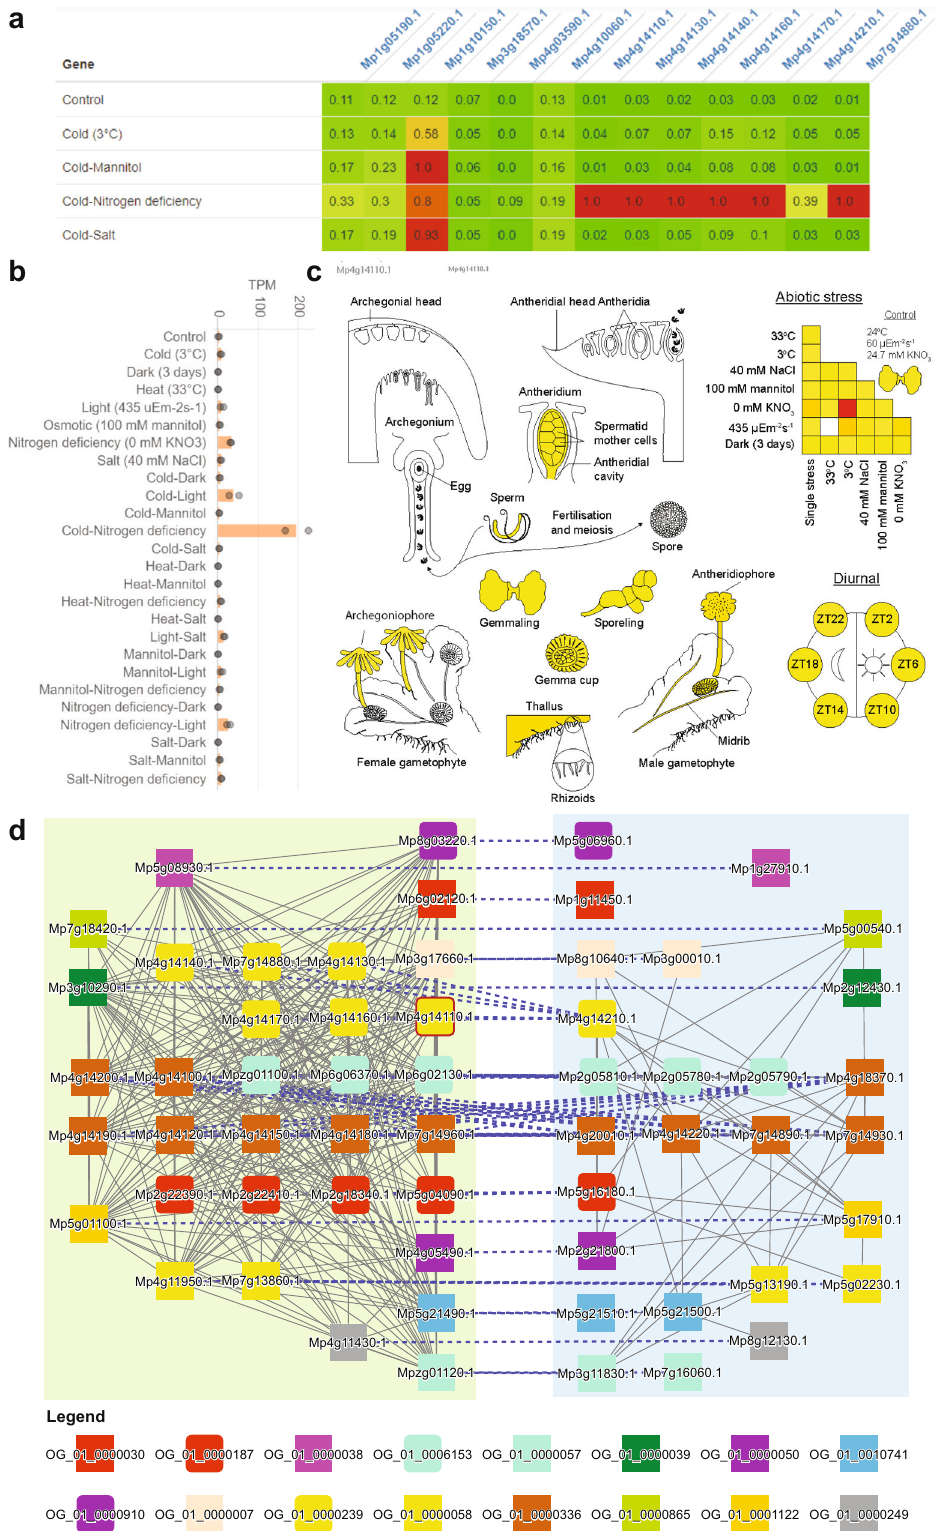
Fig.8|ImplementationoftheMarchantiageneexpressiondatainCoNekTand eFP browser. a Heatmap showing expression of PAL s in representative stresses. b Expressionpro fi leof Mp4g14110.1 (Mp PAL7 )undersingle and combined stressin CoNekt. c Expression of Mp PAL7 in different organs and under different abiotic